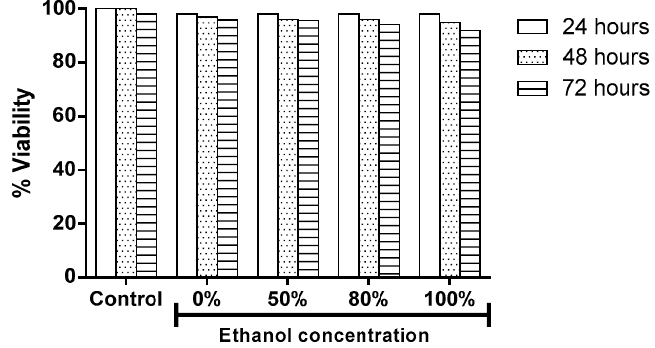
Figure 6. Ethanol concentration e ff ect on the cellular viability. Individual samples of B . x buttiana extract with 1 mg / mL of each extract 0%, 50%, 80%, and 100% for 24, 48, and 72 h were investigated to determine the viability percentage by MTT test as described in Materials and Methods. Each bar corresponds to the results (mean ± standard deviation (SD)) from three different preparations.